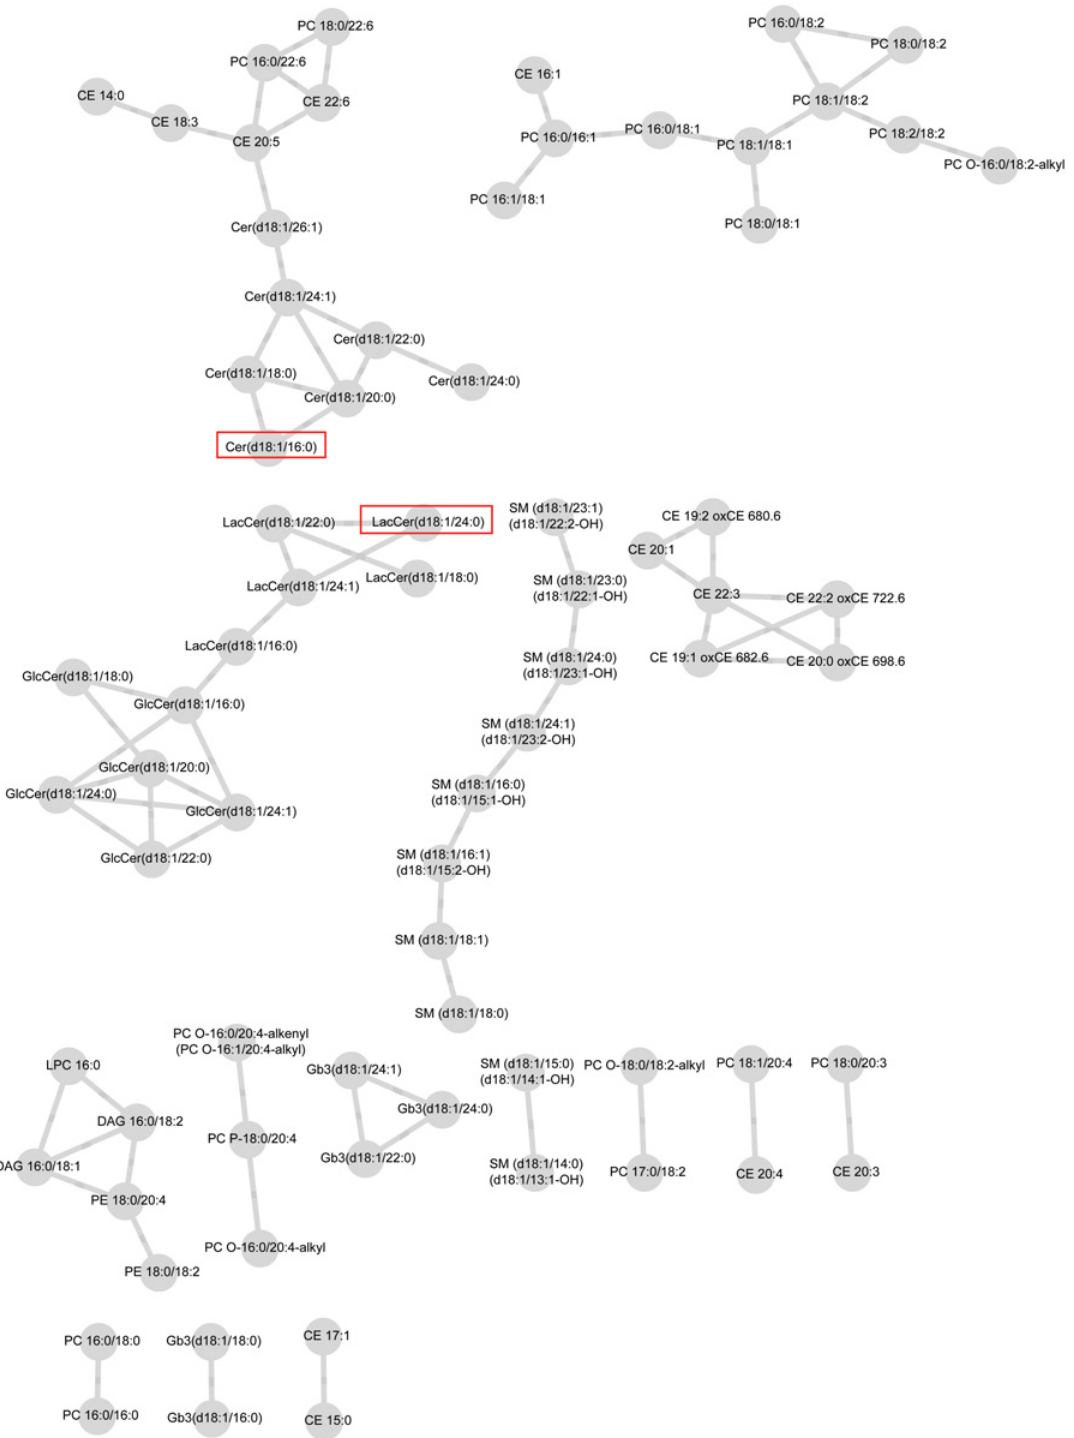
Fig 2. Lipid network for control-group with parameter values ε = 0.4 and minimum modular size = 3. Significant lipids from the test for differential connectivity of a single lipid are circulated. Modules consisting of lipids belonging to the same lipid class are highlighted with a rectangle as well.